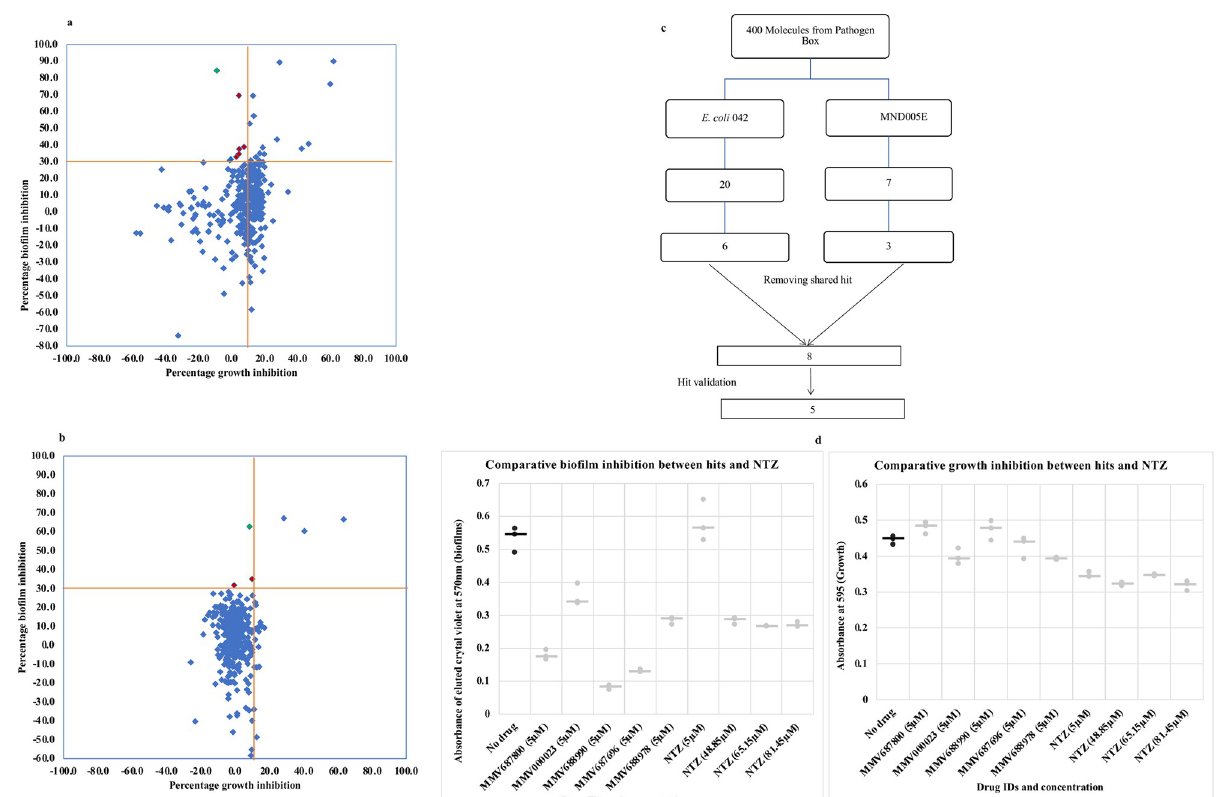
Fig 1. (a-b) Preliminary screen outcome of 400 drug-like molecules in Pathogen Box as a measure of percentage biofilm inhibition against growth inhibitions at 5 μ M for (a) EAEC strain 042 and (b) EAEC strain MND500E. Each compound except the antibiofilm hits is represented by a blue diamond. Compounds in the top portion of the scatterplot (above the horizontal red line) show > 30% biofilm inhibition activity and those to the left of the vertical line additionally inhibit growth by < 10%. The number of initial hit candidates (colored red) was six for 042 in (a) and three for MND005E in (b). (c) Hit progression cascade leading to 5 validated EAEC biofilm non growth inhibiting compounds. A total of 8 hits were obtained (One hit inhibited biofilms without inhibiting growth in both strains), but only five (validated hits) reproducibly inhibit biofilms in EAEC. (d) Biofilm inhibition (left) and growth inhibition (right) of hit compounds and nitazoxanide against (042). The black dots represent drug-free controls while the ash dots represent outcomes with drug treatment. Overall, five hits inhibited biofilm formation by over 30% while inhibiting growth by under 10%. NTZ showed activity but not within the range of these cut-offs. Bars represent the median for replicates in all